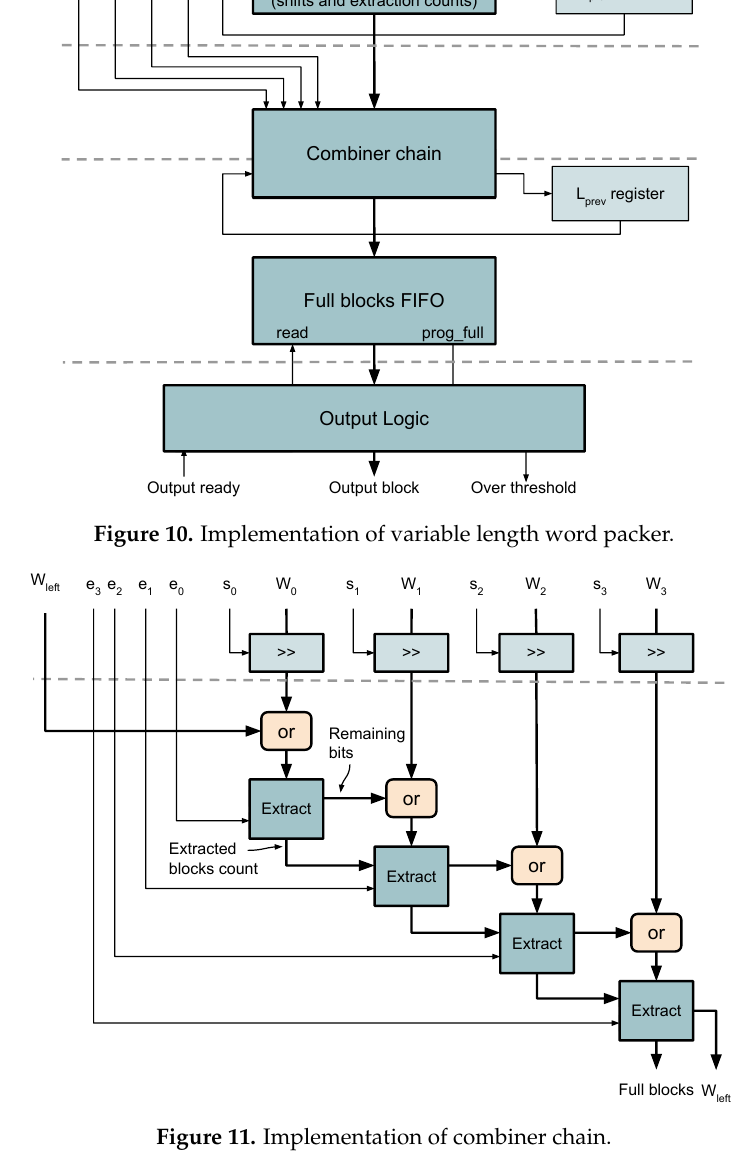
Figure 11. Implementation of combiner